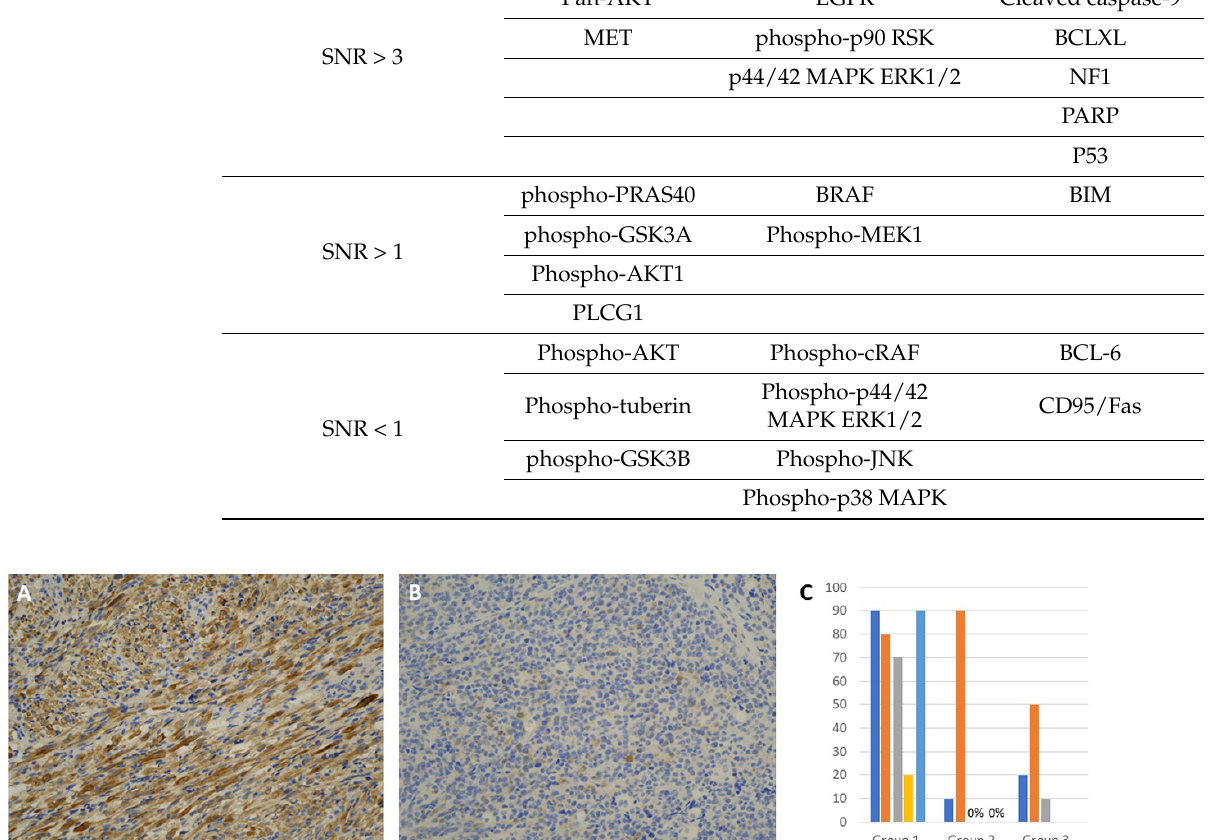
Table 2. Expression levels of signaling pathway proteins in RMS (all groups combined) as determined by DSP analysis of signal to noise ratio (SNR).